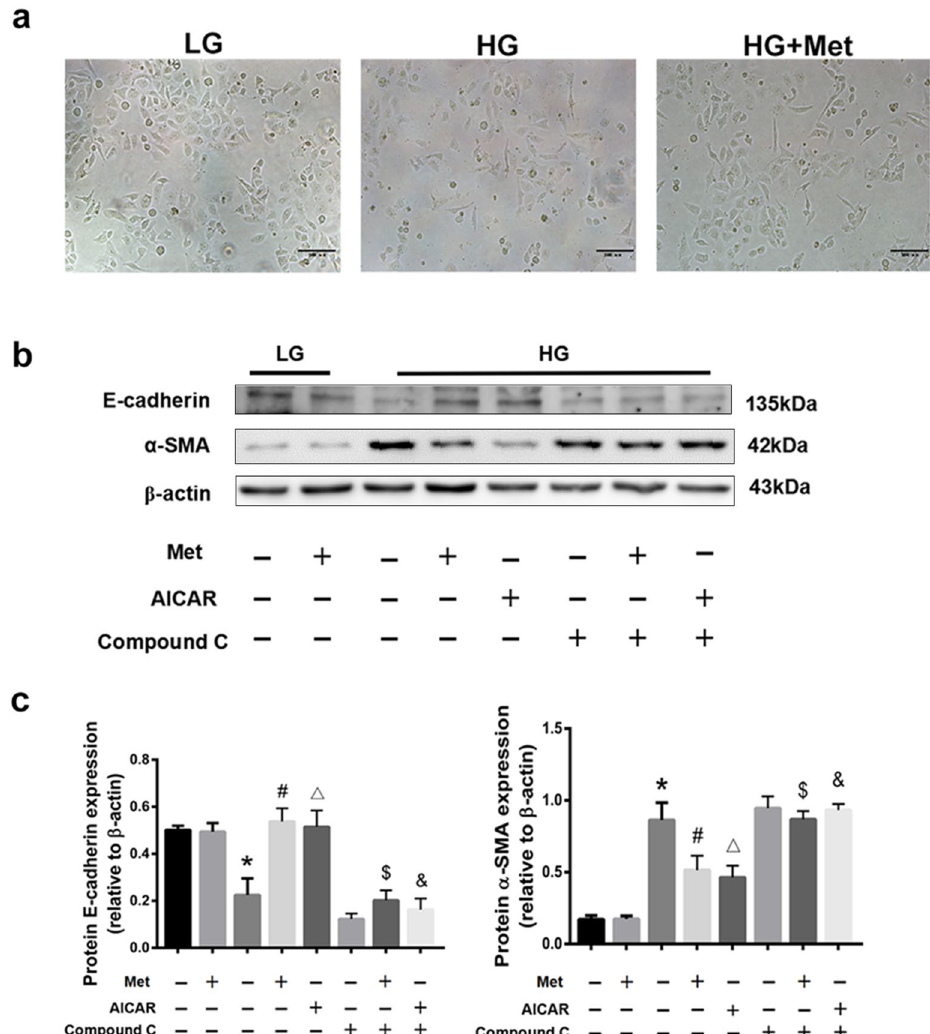
Figure 6. Effects of AMPK activators and inhibitors on the partial EMT of HG-stimulated RTECs. ( a ) Morphological changes of RTECs under different environments. ( a ) Western blot analysis of E-cadherin and α-SMA after different treatments. The boxes indicate images from different gels, but the samples derived from the same experiment and blots were processed in parallel. ( c ) Statistical analysis of E-cadherin and α-SMA in each group. * P < 0.01 compared with the LG group, # P < 0.01 compared with the HG without metformin group, △ P < 0.01 compared with the HG group, $ P < 0.01 compared with HG + Met group, & P < 0.01 compared with HG + AICAR group. Full-length blots were presented in Supplementary